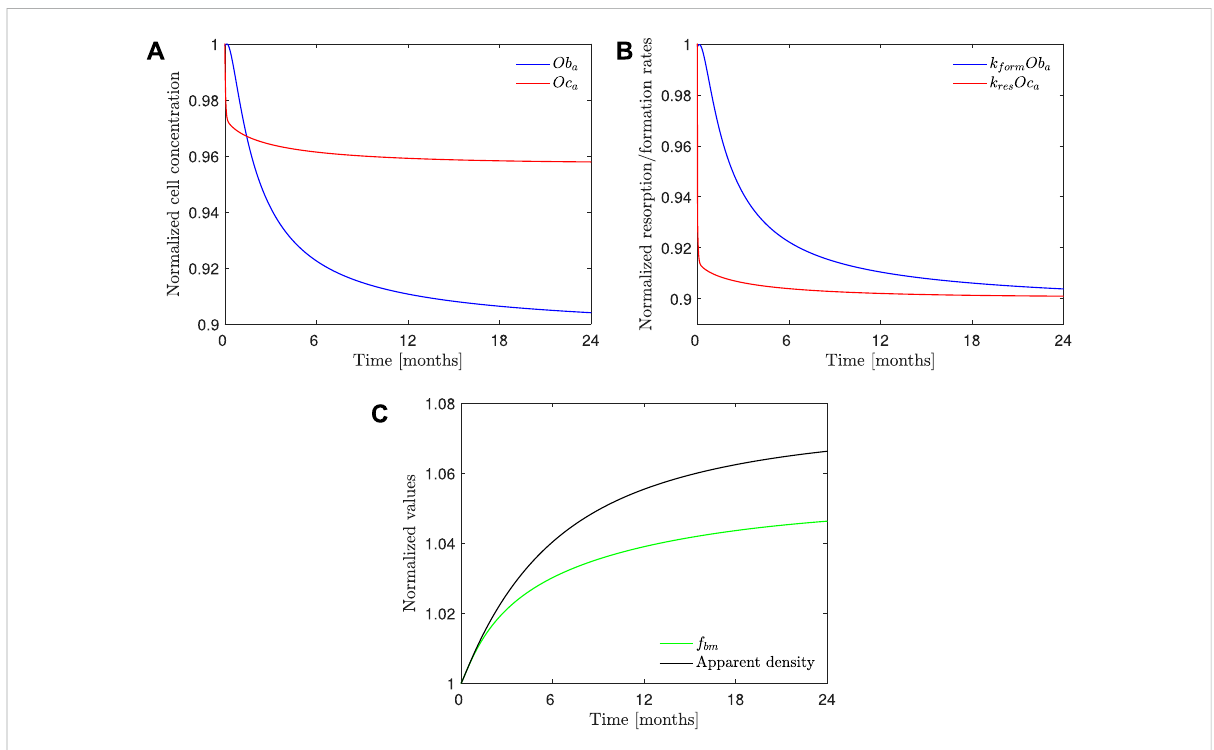
FIGURE 10 PK-PD1 model results of 70 mg weekly treatment of alendronate in the case of the hip. Temporal evolution of (A) osteoblasts and osteoclasts concentration; (B) boneresorptionandformationrates; (C) apparentdensityand f bm .Alltheresultsarenormalizedwiththevaluesatthebeginningof the